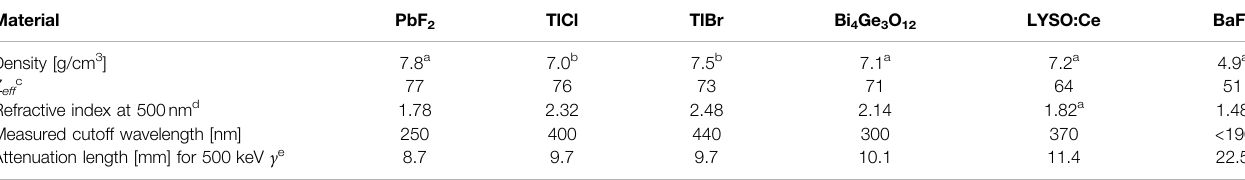
TABLE 1 | Physical properties of the Cherenkov radiators under study and scintillating crystals for comparison. Material